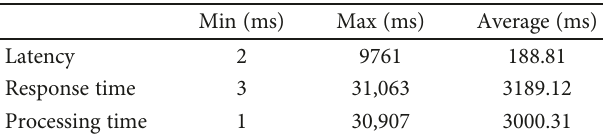
Table 2: Test result of the blanket mode (performance measurements).